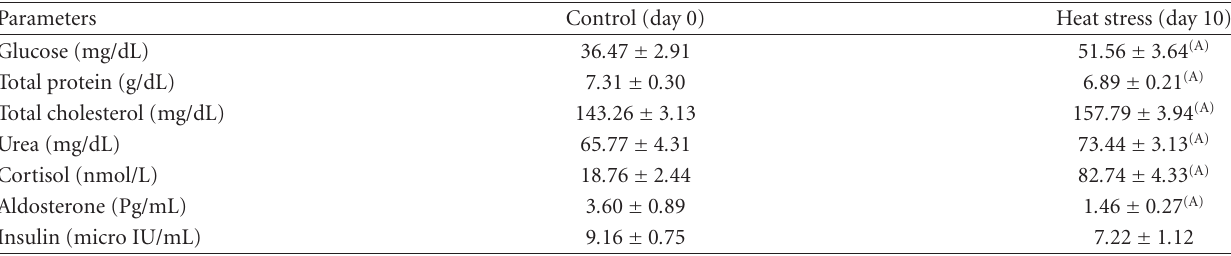
Table 1: Mean and SE of biochemical and endocrine parameters studied in control and heat exposed goats. Mean and SE are based on 6